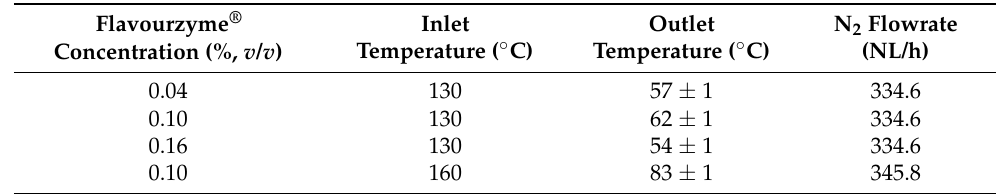
Table 1. Operating conditions in Flavourzyme ® encapsulation with Mini Spray Dryer Buchi B-290 (aspirator rate 90%, liquid feed flowrate 6.4